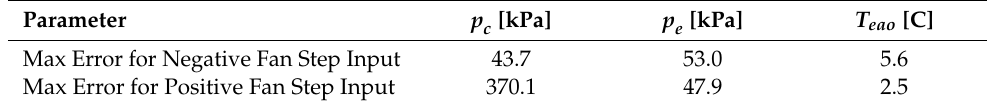
Table 5. Maximum error between VEM and NL models for fan step input